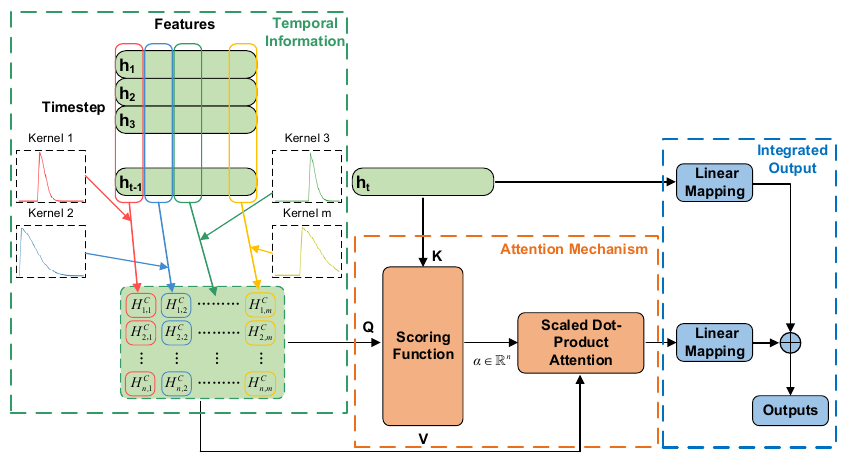
Figure 4. Attention layer structure diagram. Where n = t − w , t is the length of time step of input data; w is the size of the convolution kernel; and m is the characteristic number of input data.